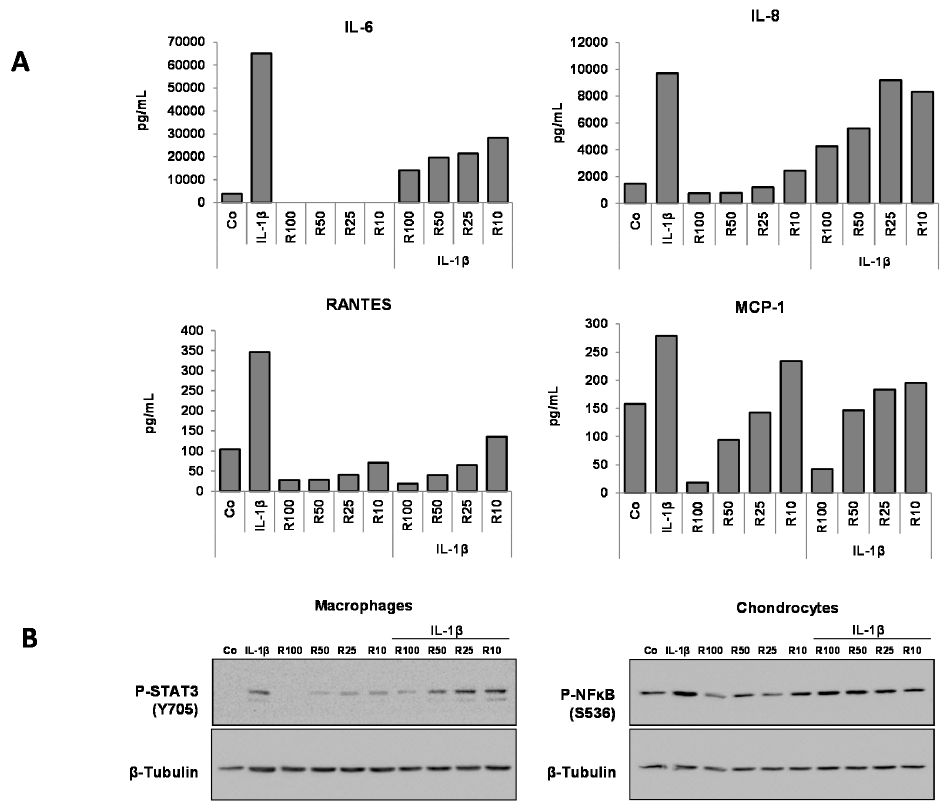
Figure 4. Resveratrol effect on the expression levels of IL ‐ 6, IL ‐ 8, Rantes, MCP ‐ 1 and on the expression of p ‐ NF ‐κ B and p ‐ STAT3 in HcH and M Φ cocultures and influence of the IL ‐ 1 β treatment. ( A ) ELISA estimation of the level of IL ‐ 6, IL ‐ 8, Rantes, MCP ‐ 1 in culture medium. Representative data from one of three experiments are shown; ( B ) Western blotting assessment of the expression of p ‐ STAT3 in HcH and M Φ cocultures. β‐ Tubulin: protein loading control, Co: control. Resveratrol (R) in μ M. Pg/mL: picogram/mL. Representative data from one of three experiments are shown.